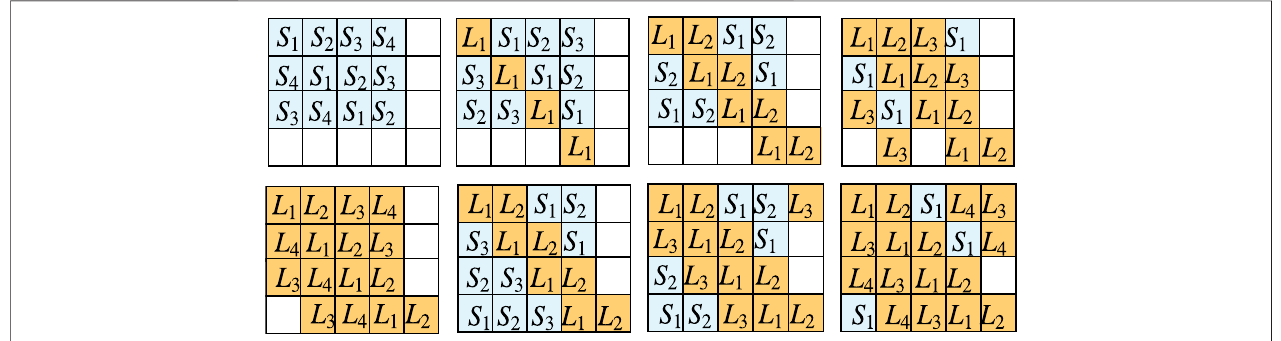
FIGURE 4 | This fi gure shows the distribution of the short states and long states for constructing SUEB 3 in C 4 ⊗ C 5 with cardinality N varying from 12 to